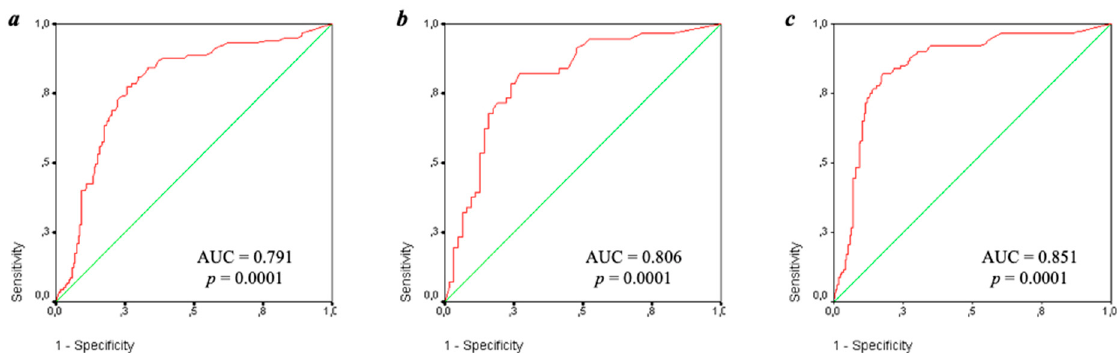
Figure 2. ROC-curves IgA aCL depending on thrombosis ( a ), obstetric pathology ( b ), and reliable antiphospholipid syndrome ( c ). Note: AUC-area under curve, p